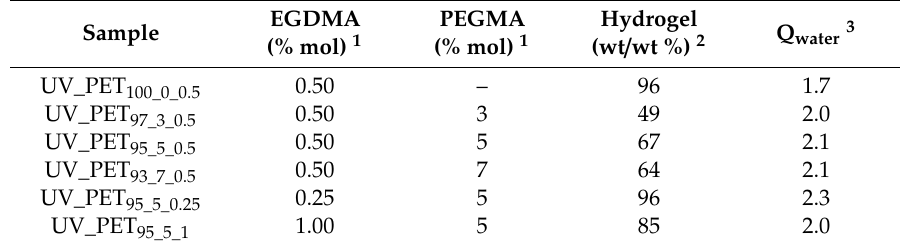
Table 1. Surface modification of polyethyleneterephtalate (PET) fabric with hydrogel using the photochemical method ( λ = 350 nm); water was used as